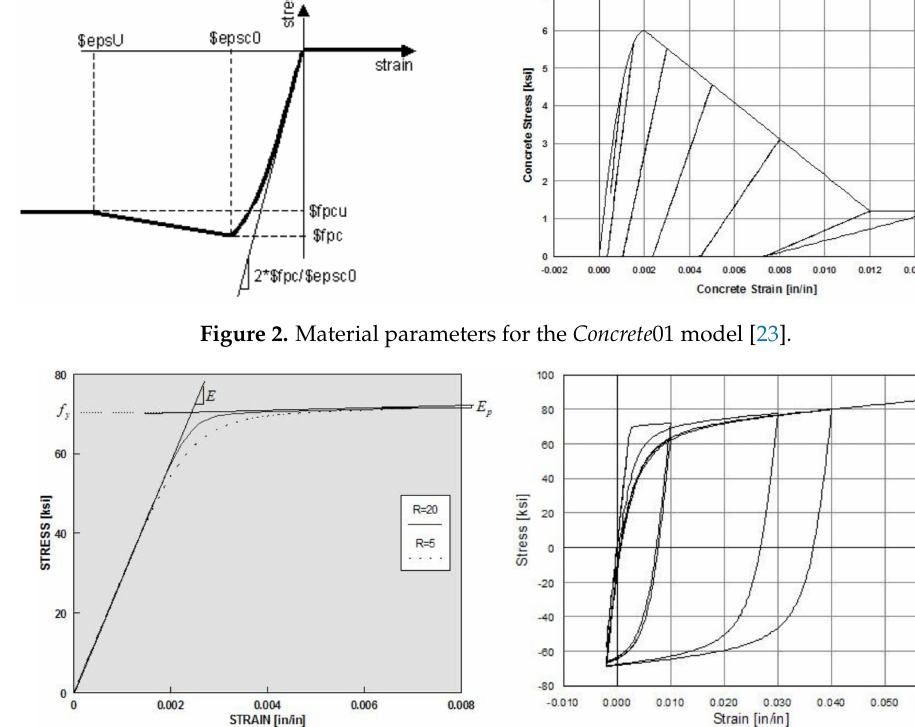
Figure 3. Hysteretic response of steel bars with the Steel 02 model